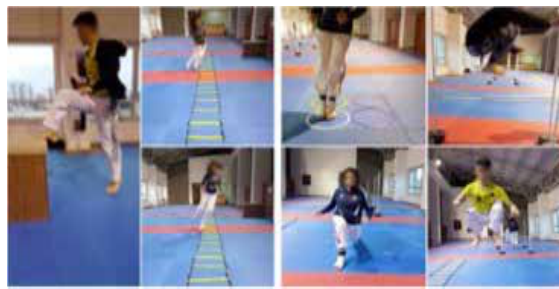
Figure 2. Blood Flow Restriction